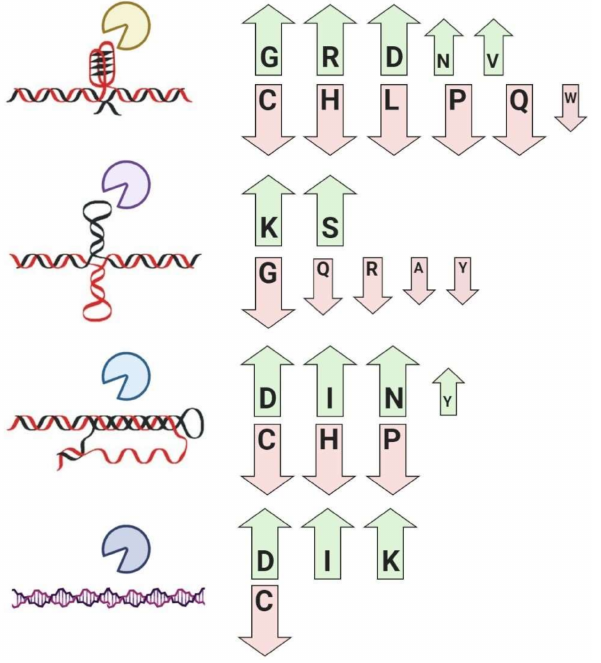
Figure 1. Significantly enriched and depleted amino acid residues (one letter aa code) in the dataset of G-quadruplex binding proteins (top), cruciform binding proteins, triplex binding proteins, and Z-DNA-binding proteins. Using Bonferroni correction, only values lower than 0.0025 were taken as significant ( p <0.0025; p <0.0010; p <0.0001). The size of arrows indicates the significance of enrich- ment/depletion on scale (highest, moderate, lowest). Figure compiled using data from [47,48,89]. Created with